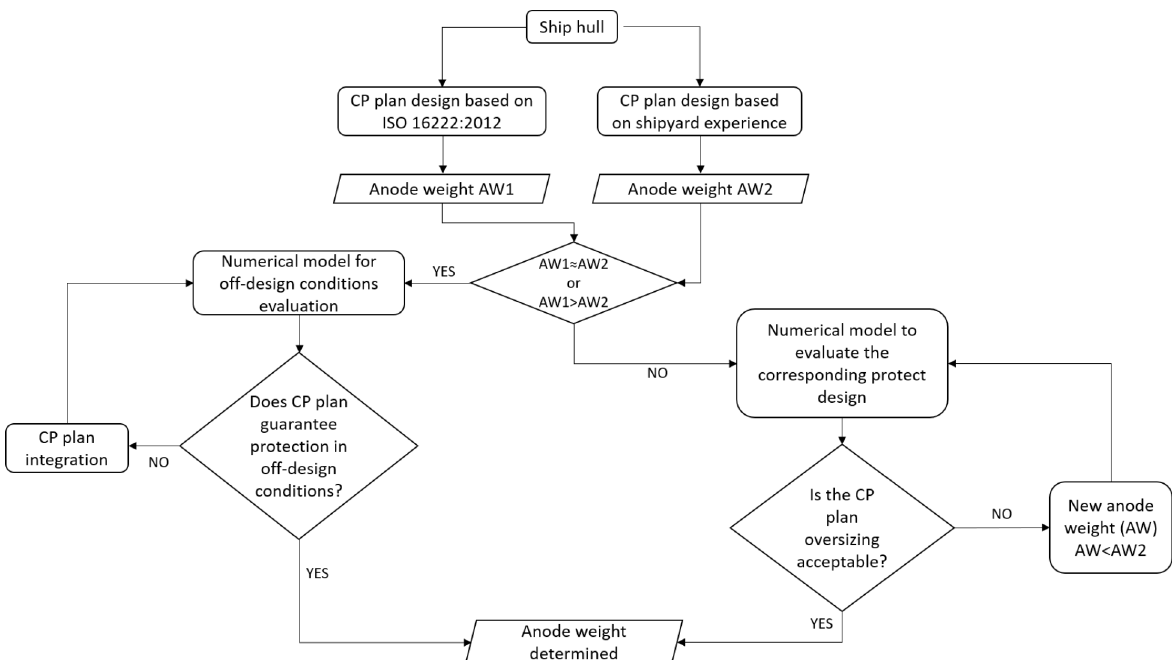
Figure 2. Flowchart of the proposed